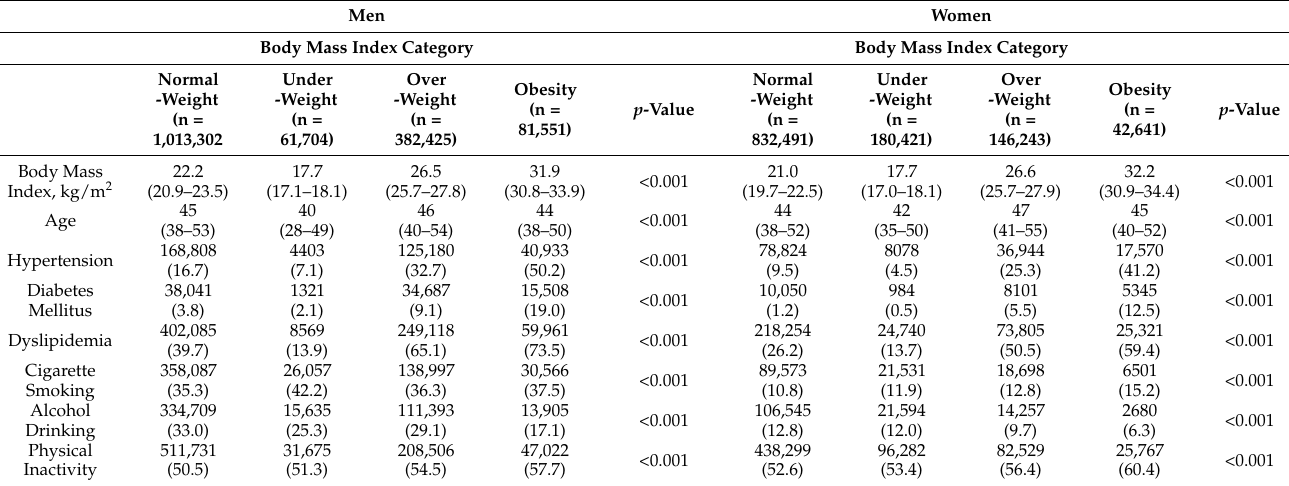
Table 1. Clinical Characteristics of Study